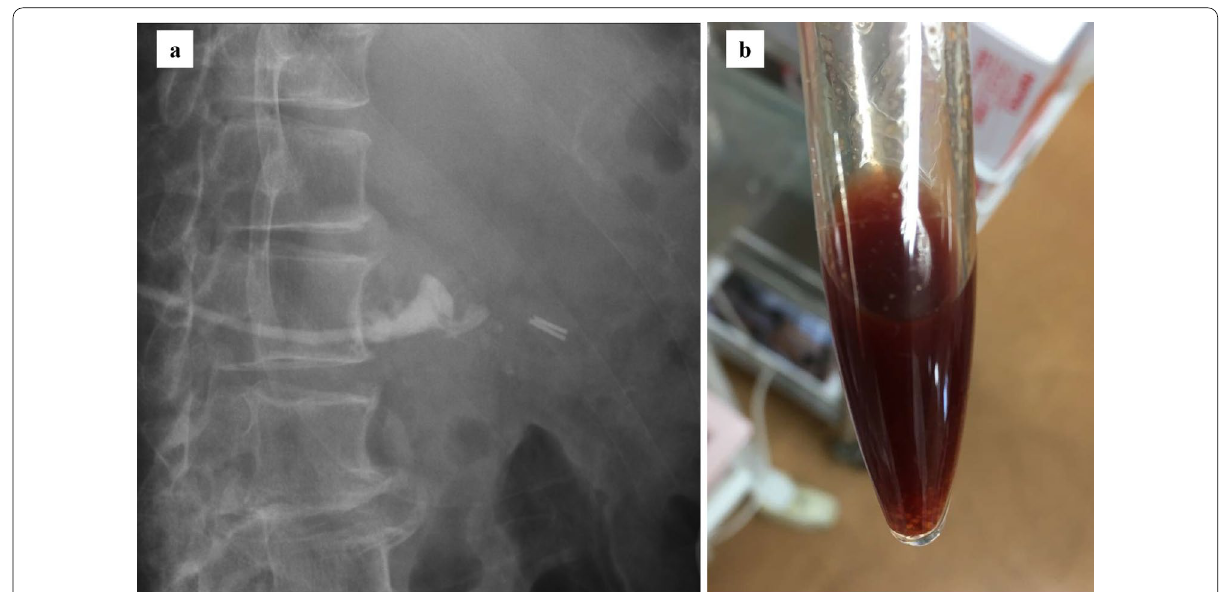
Fig. 3 Percutaneous hepatic abscess drainage. a Percutaneous drainage was performed using an 8 Fr pigtail catheter. b Drainage fluid was red– black and had a foul odor